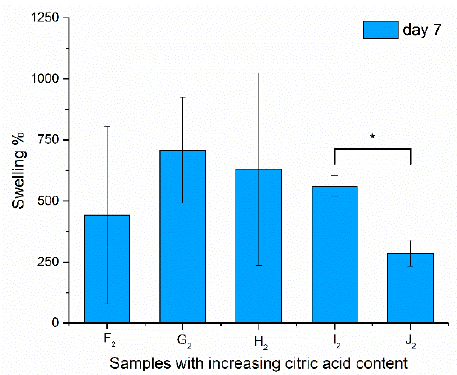
Figure 7. Swelling properties of the samples after being immersed in water for 7 days (due to high standard deviation, no significance was found at p > 0.1, but I 2 –J 2 are indicated with *).